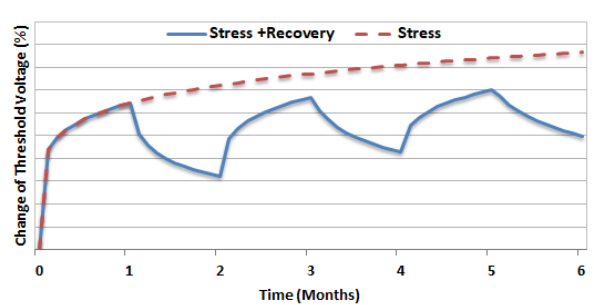
Figure 1: Threshold voltage shift of a PMOS transistor under NBTI effect.